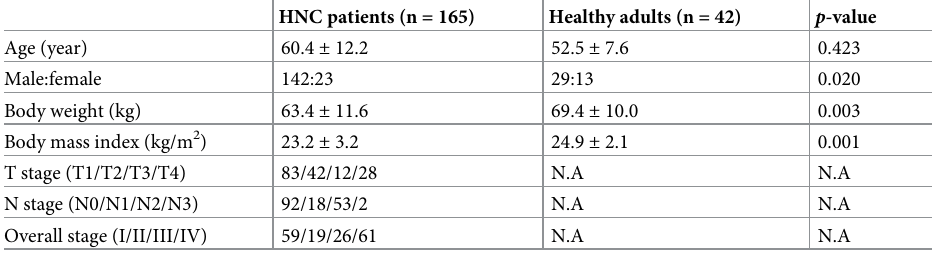
Table 1. Clinical characteristics of study subjects.